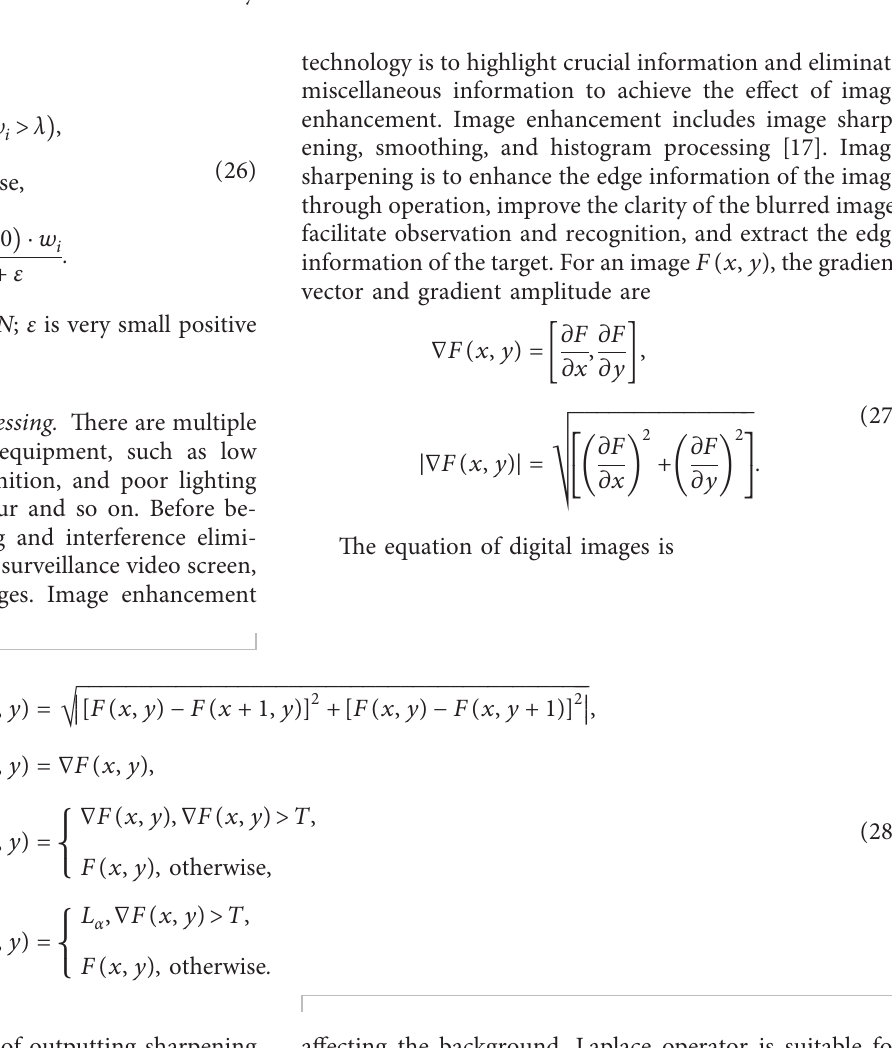
Figure 6: Memory enhancement